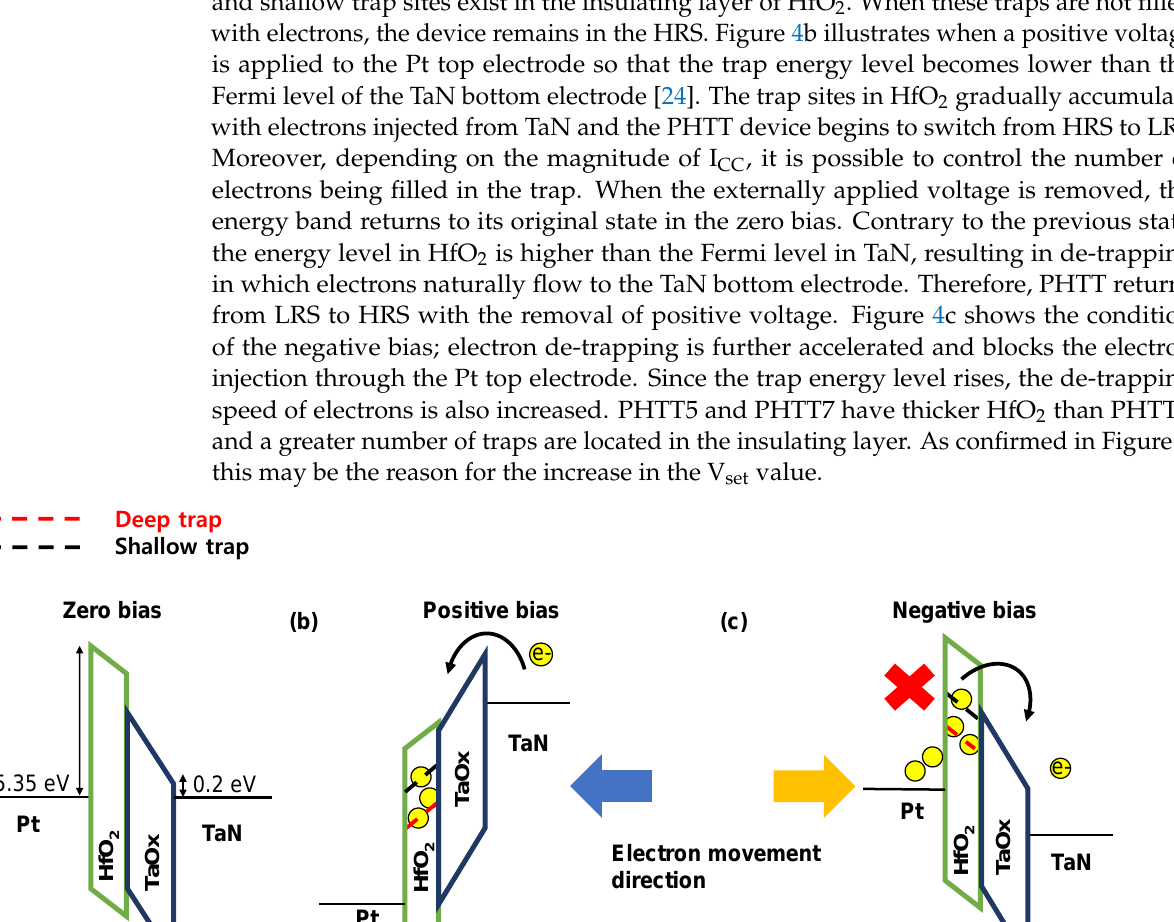
Figure 4. Band diagram schematic of PHTT device. ( a ) Zero bias condition. ( b ) Positive bias condition. ( c ) Negative bias condition.